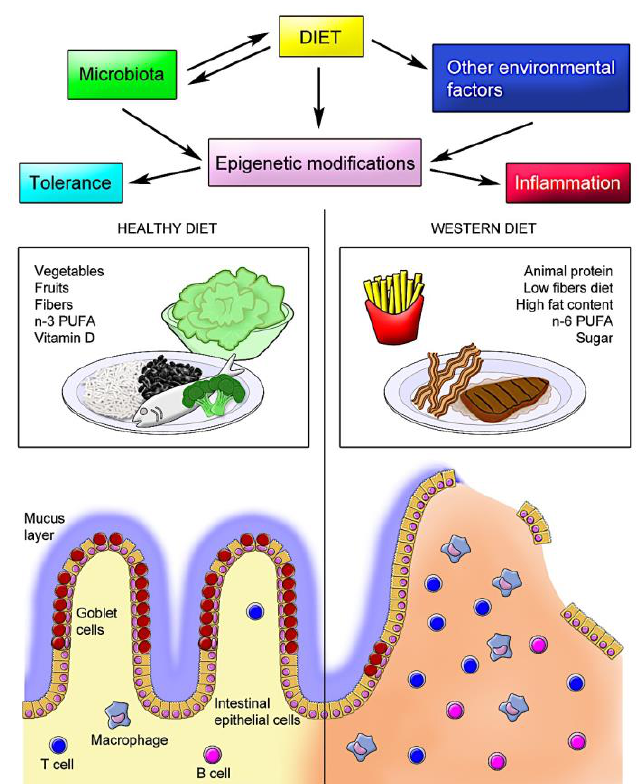
Figure 1. Schematic model of diet–host interactions in the intestine. The interaction between dietary elements and the intestinal mucosa is highly complex and, in normal conditions, results in a tolerogenic response. However, in genetically predisposed individuals, the interplay of specific dietary constituents with the resident microbiota and other environmental factors induces epigenetic modifications that affect the immune response, further compromising the epithelial barrier and defense mechanisms, leading to chronic inflammation, as observed in inflammatory bowel disease (IBD).